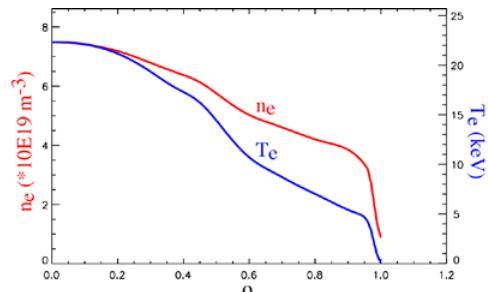
Figure 4: Equilibrium density and temperature profiles of CFETR baseline scenario